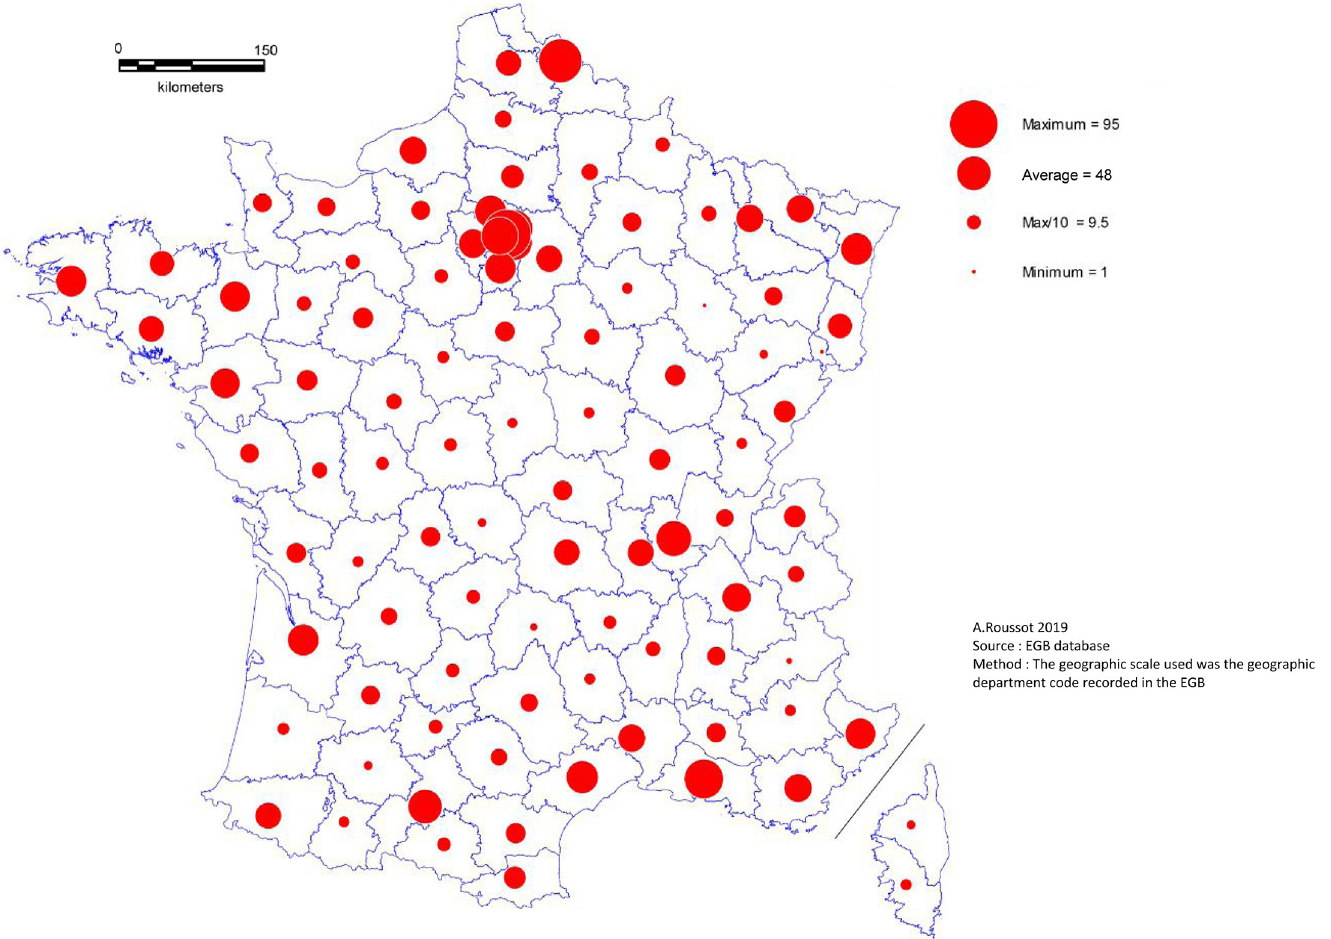
Fig 1. Geographical distribution of persons with